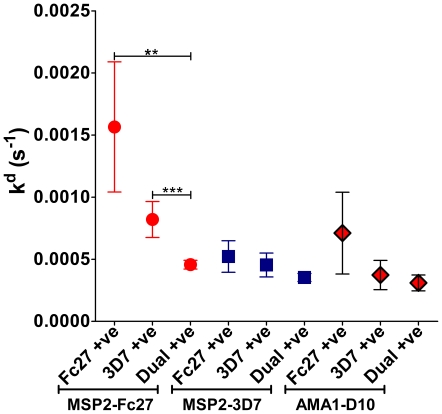
Presence of specific alleles of parasites in the blood associated with different affinities.Affinity of Tanzanian serum samples depending on which allele of MSP2 parasite was present in the blood at the time of collection. Presence of both alleles of MSP2 is associated with the highest affinity of antibodies in the sera, and that presence of the 3D7 allele was associated with higher affinity compared to the Fc27 allele. The error bars indicate mean ± SEM, and the asterisks indicate the level of significant differences (ns = p>0.05; * = p<0.05; ** = p<0.01; *** = p<0.001).